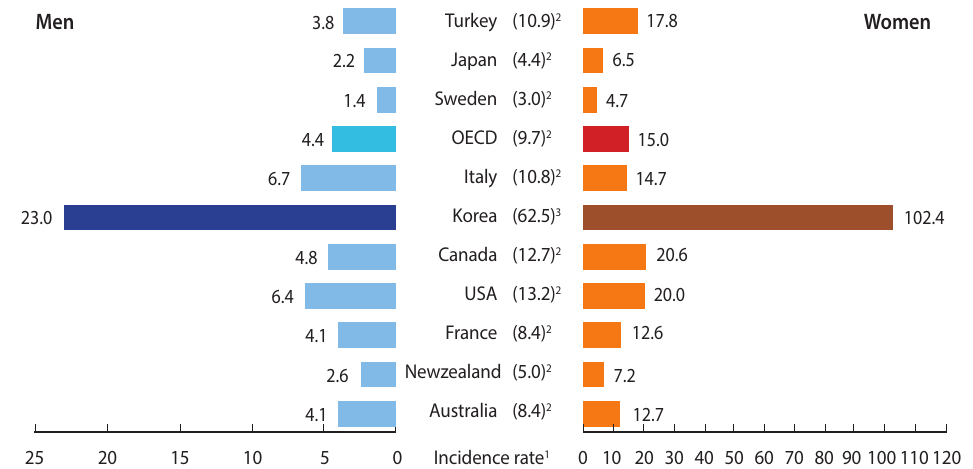
Figure 1. International comparisons of incidence rates of thyroid cancer. OECD, Organization for Economic Cooperation and Development. Adapted from: 1 The standard population per 100,000 people was calculated using Segi’s world standard population; 2 The estimated inci- dence rate in 2012 based on the data from GLOBOCAN 2012, International Agency for Research on Cancer, 2013; and 3 The observed inci- dence rate in year 2012 was obtained from the Korea Central Cancer Registry.